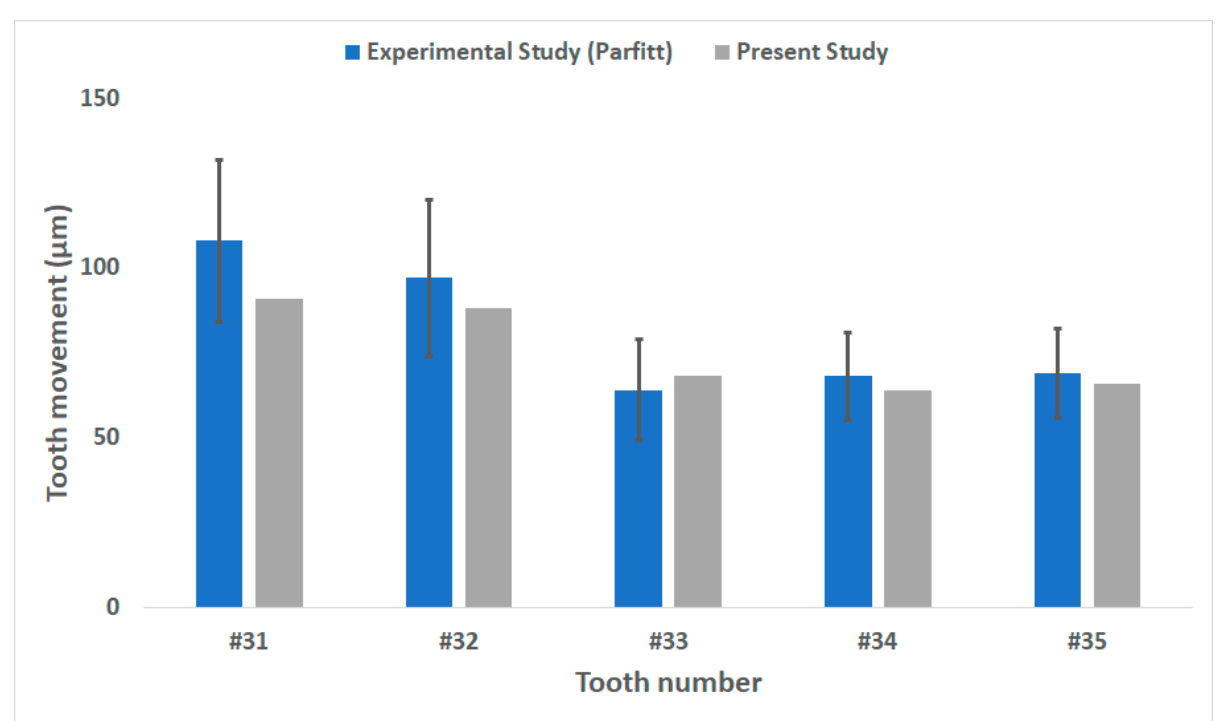
Figure 6. Validation of the intact dental FE model with tooth mobility analysis measurements.